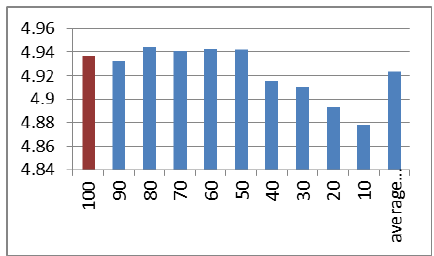
Figure 16. Average odontometric parameters at different section rates.